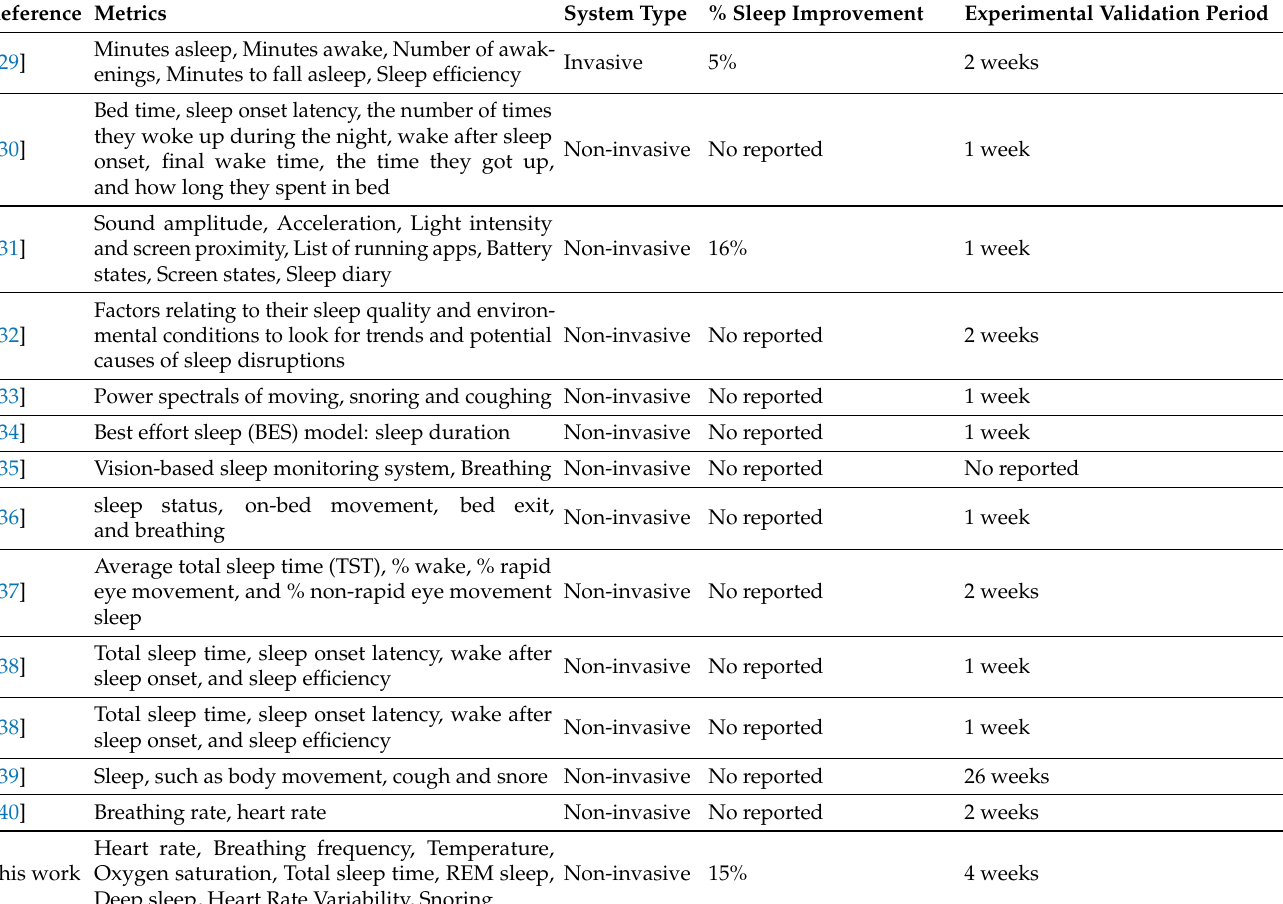
Table 1. Comparison of metrics with related work to sensors and/or wearables for sleep